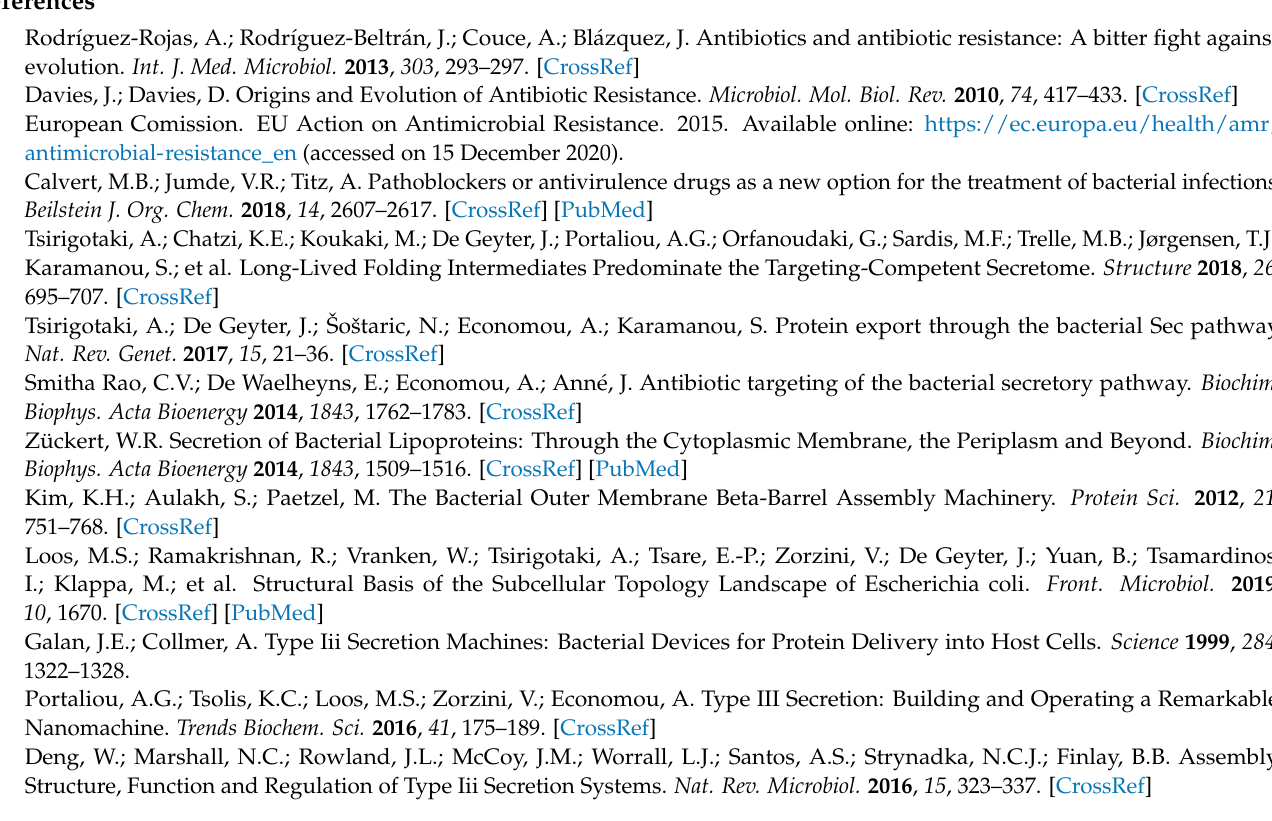
Figure S5: Effect of compounds on SecA-dependent basal ATPase activities in vitro, Figure S6: Effect of compounds on Sec-dependent translocation ATPase in vitro, Table S1: Bacterial strains used in this study, supplementary materials and